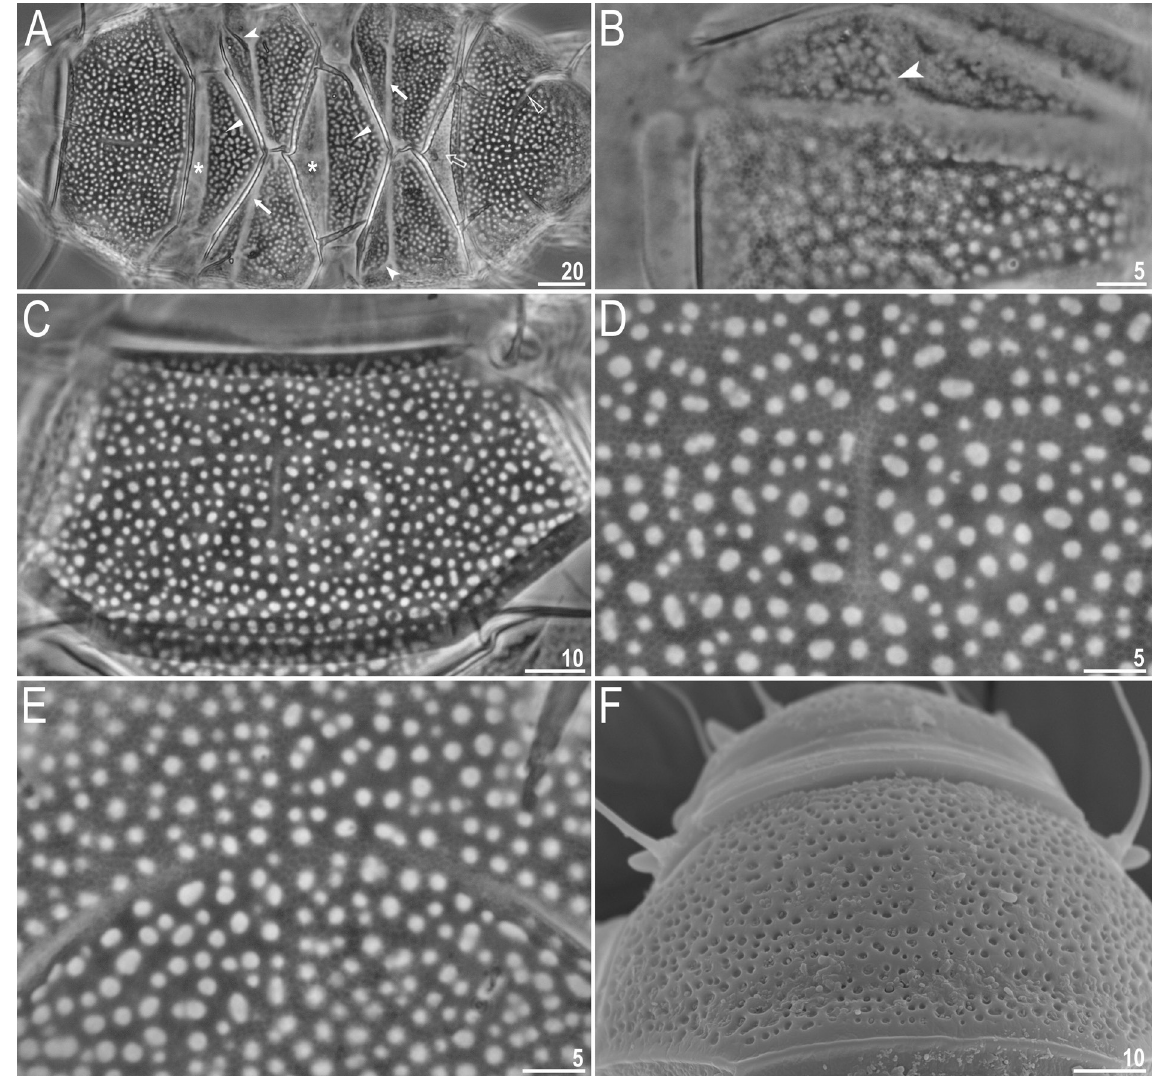
Fig. 2. Echiniscus quadrispinosus Richters, 1902, ♀. A . Close-up of the dorsal plates; arrows indicate smooth stripes dividing paired plates I and II into anterior and posterior part; indented arrowheads indicate longitudinal division of anterior part of paired plates; asterisks indicate anterior part of median plates I and II whereas filled arrowheads indicate posterior parts; empty arrow indicates median plate 3; empty arrowhead indicates notches on terminal plate (PCM). B . Close-up of the paired plate II; indented arrowhead indicates longitudinal division of anterior part of the plate (PCM). C–D . Close-up of the scapular plate sculpture (PCM). E . Close-up of the terminal plate sculpture (PCM). F . Close-up of the scapular plate (SEM). Scale bars in micrometres